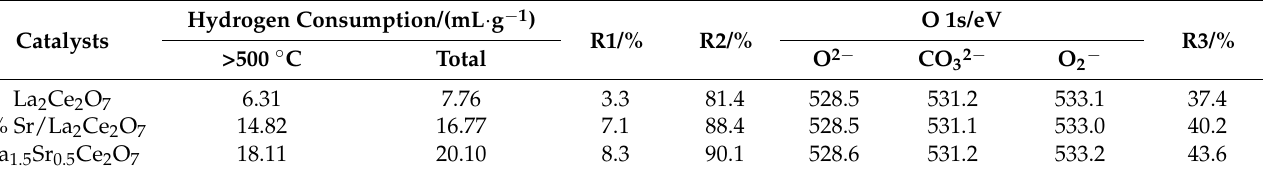
Figure 9. XPS O 1s spectra of the indicated catalysts [89] . Table 4. H 2 -TPR and XPS results of the catalysts